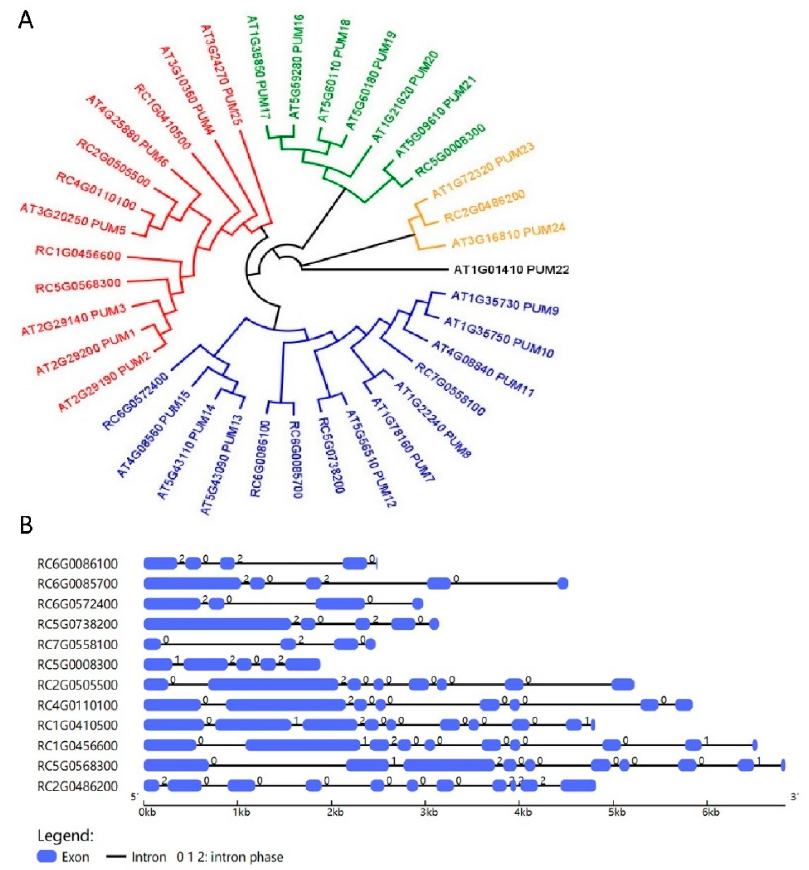
Figure 4. Identification of PUF members in Rosa chinensis . ( A ) Phylogenetic tree of PUF members in Arabidopsis thaliana and Rosa chinensis. The maximum likelihood analysis in the MEGA program was used to build the phylogenetic tree. The PUF sequences of Rosa chinensis and Arabidopsis thaliana were downloaded from the GDR (https://www.rosaceae.org/) and TAIR (https://www.arabidopsis.org/) databases, respectively. ( B ) Gene structure dynamics of PUF members in Rosa chinensis . The gene structures of RcPUF members were obtained using GSDS software (http://gsds.cbi.pku.edu.cn/).